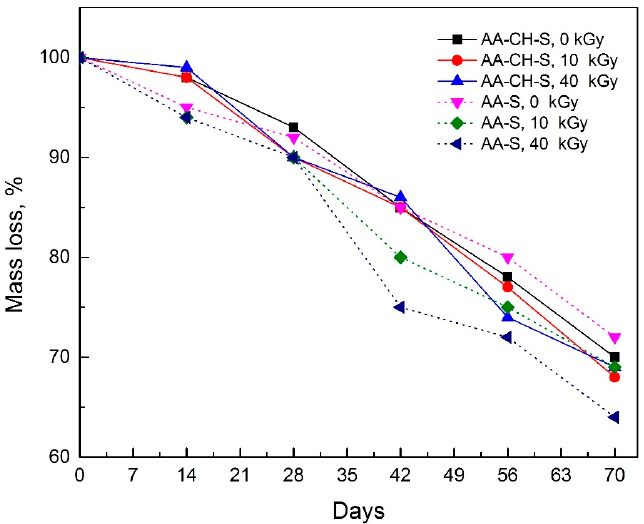
Figure 10. The degree of biodegradability in activated sludge was measured by the mass loss of the AA-S and AA-CH-S films exposed to 10 and 40 kGy radiation doses.